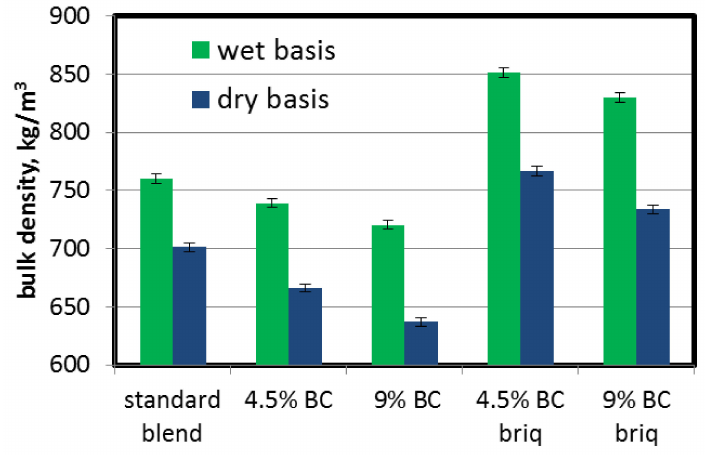
Figure 3. Influence of lignite addition on coal charge bulk